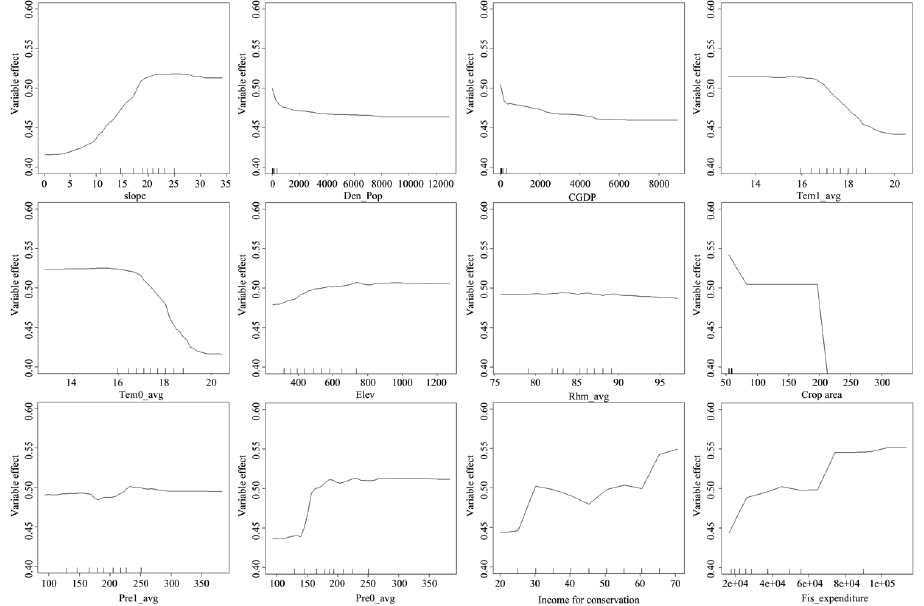
Figure 5. Partial dependence plots for variables predicting vegetation cover change, selected using Random Forest. Partial plots show the effect of each variable on vegetation cover change. Note: the abbreviated variable names are the same as in Table 1.